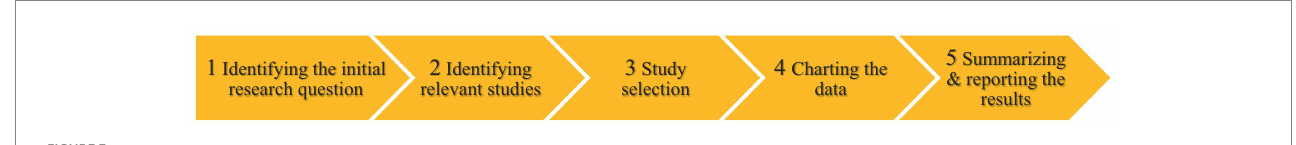
FIGURE 3 Arksey and O’Malley’s (2005) five-stage